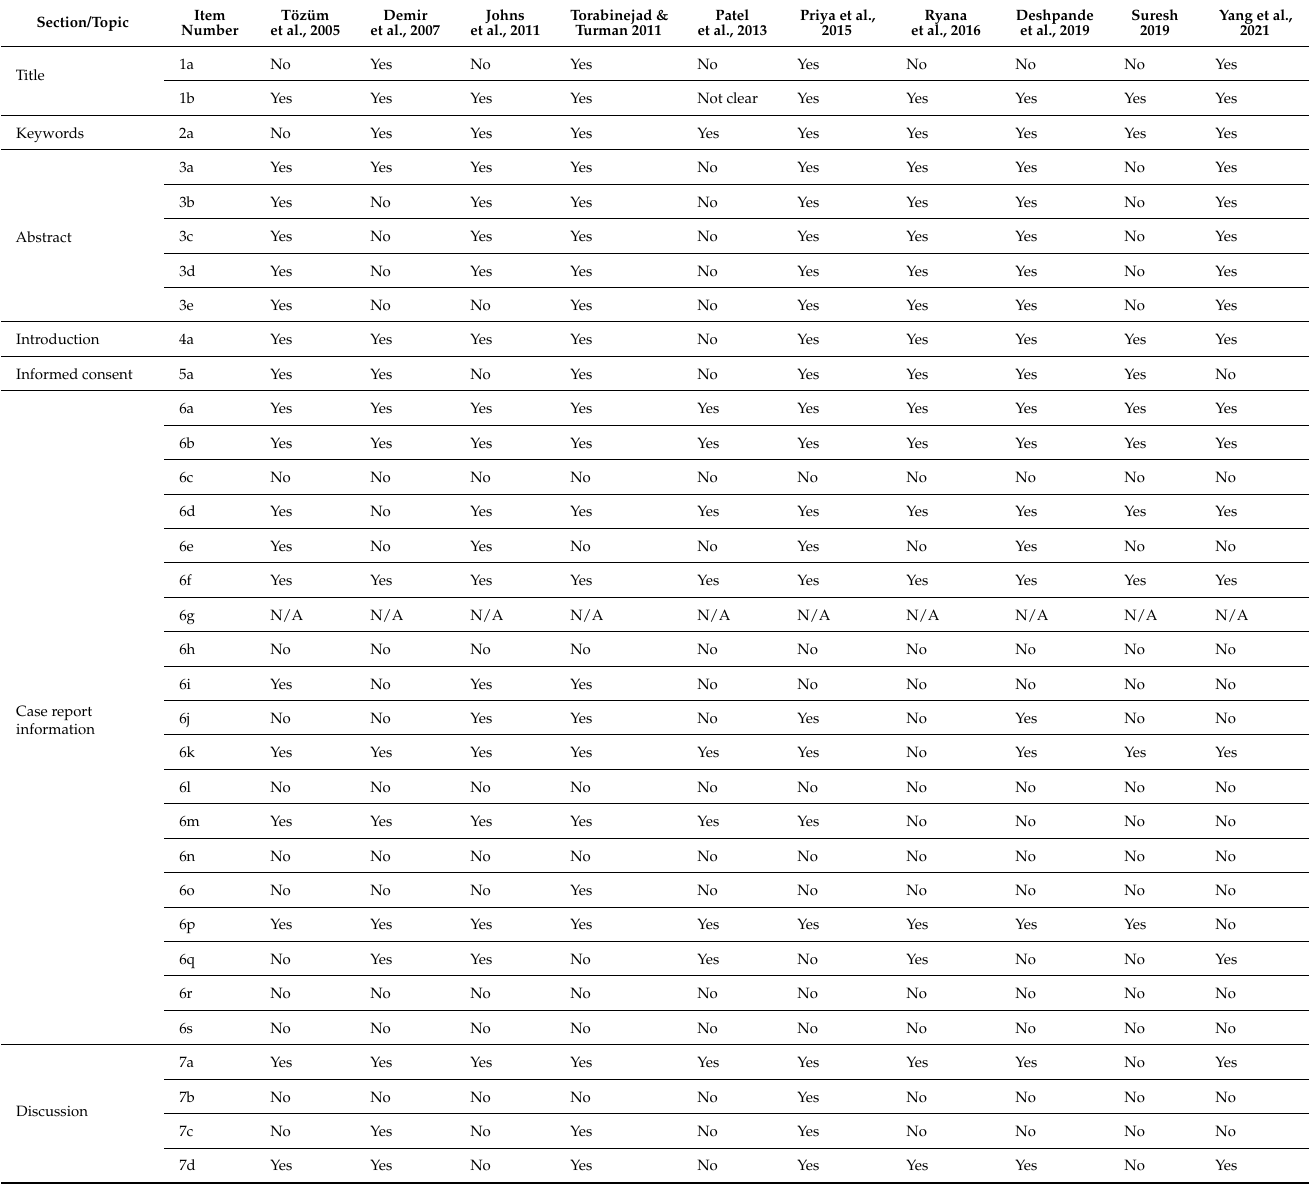
assessed is provided in the additional supplementary